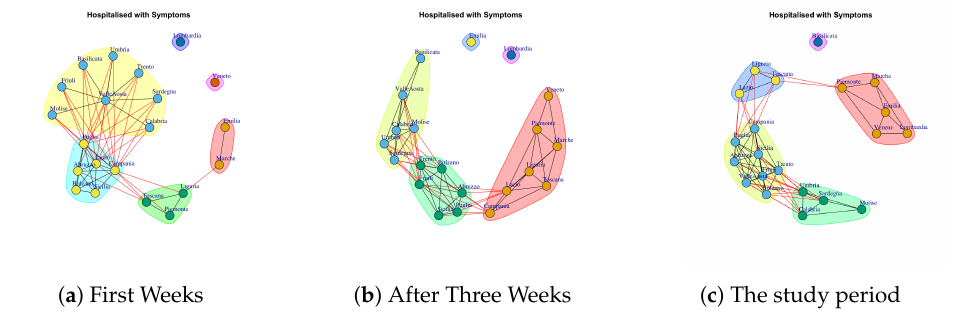
Figure 14. Evolution of Hospitalized with Symptoms Network Communities.